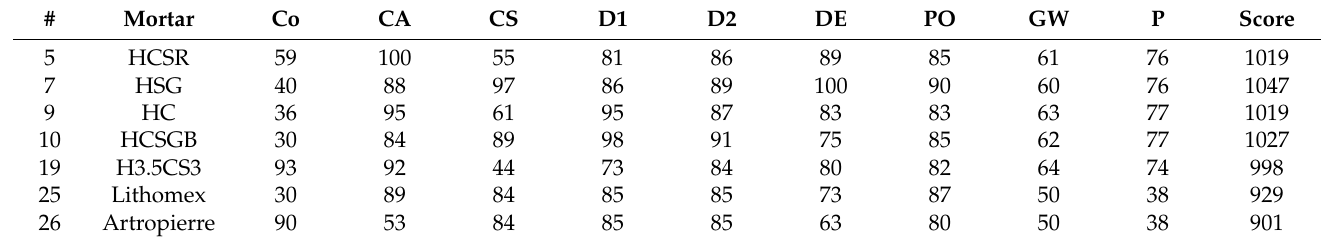
Table 12. Scores of selected mortars for Euville stone in the Royal Palace with weighed coefficients (Equation